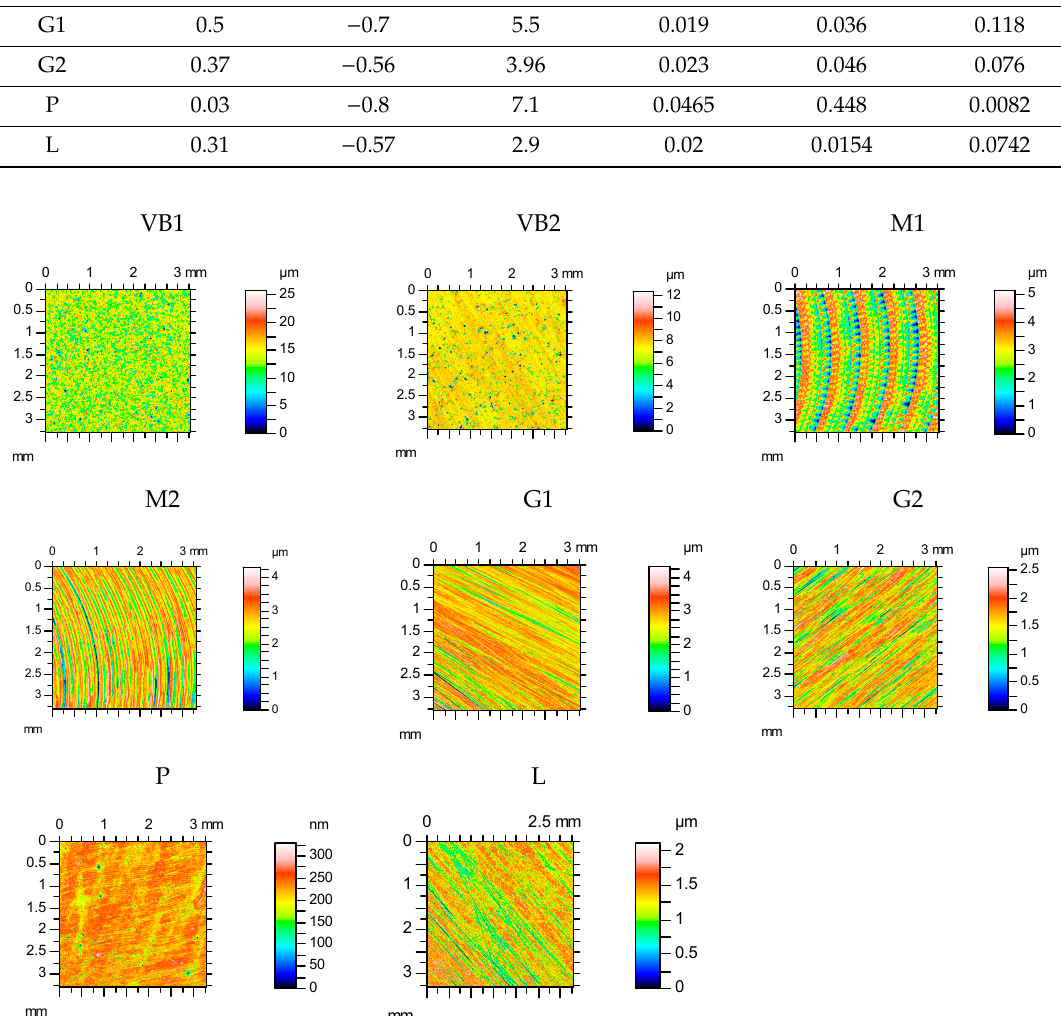
Figure 1. Contour maps of disc surfaces: after vapour blasting VB1 and VB2, after milling M1 and M2, after grinding G1 and G2, after polising P and after lapping L.